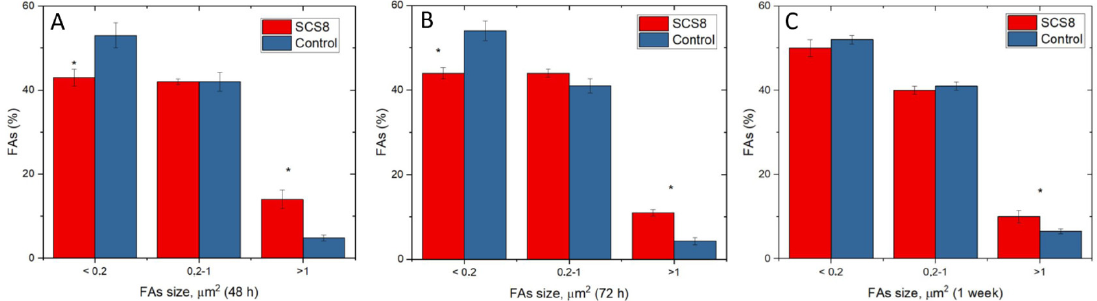
Figure 15. Percentage of FAs according to size. Comparative analysis between cells grown on SCS8 and control groups at ( A ): 48 h in culture; ( B ): 72 h hours in culture; ( C ): 1 week in culture. Data are quantified in Image J (*); p < 0.05.